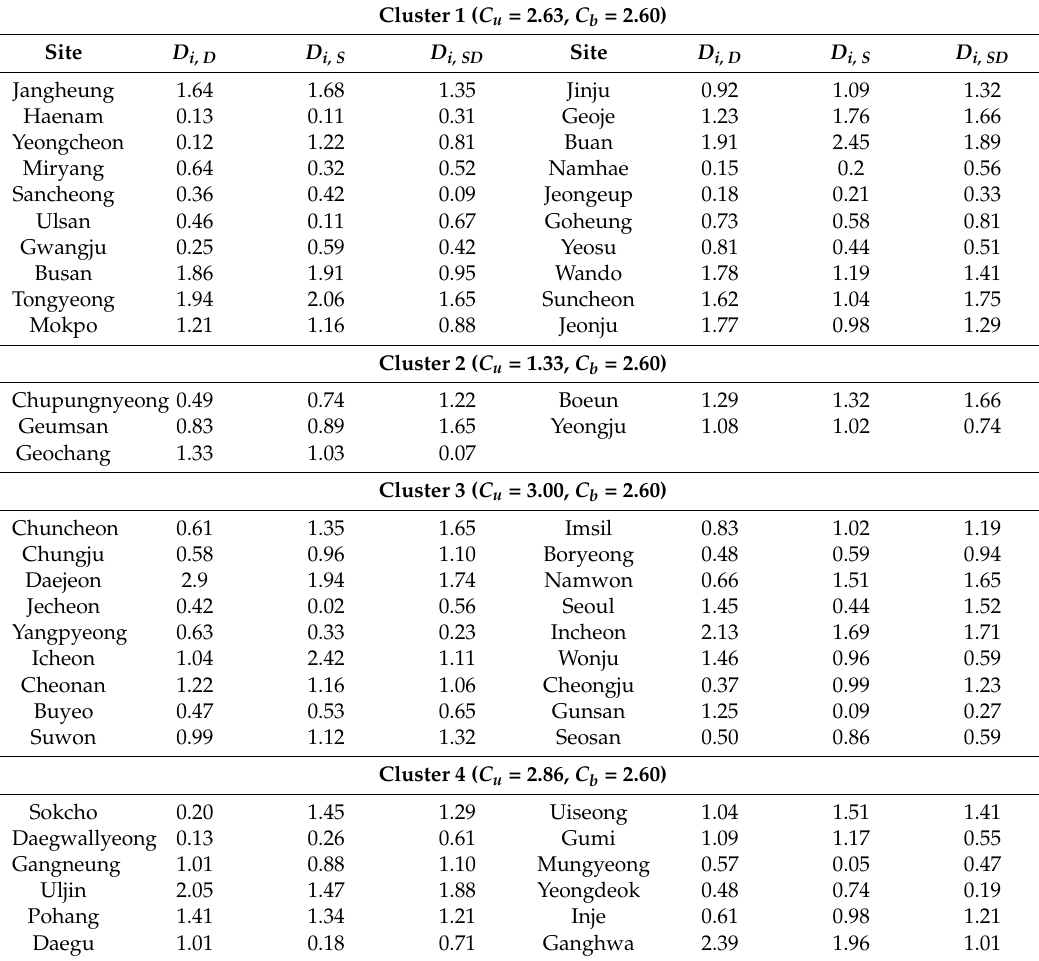
Table 4. Results of univariate and bivariate discordancy measure for the final adjusted homogeneous regions using SPI-6. C u and C b indicate the critical values of discordancy measure for univariate and bivariate cases,